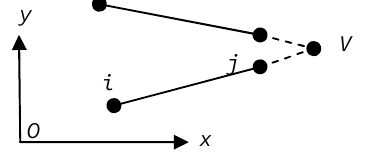
Figure 2. Geometric relationships between observational line and vanishing point Ideally, i , j and V is collinear, so observational equation